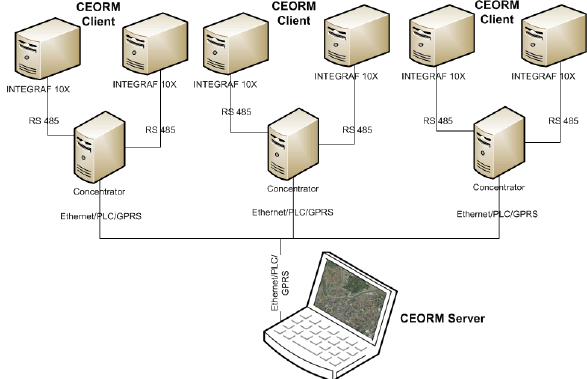
Figure 3. Communication in CERM